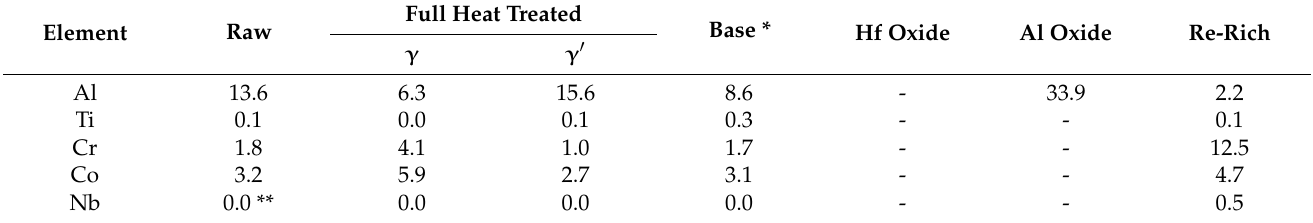
Table 1. Compositions (at %) of raw material, γ and γ (cid:48) phases measured in a fully heat-treated blade [24–26], the base material, hafnium oxide and aluminium oxide, and a Re-rich particle measured by